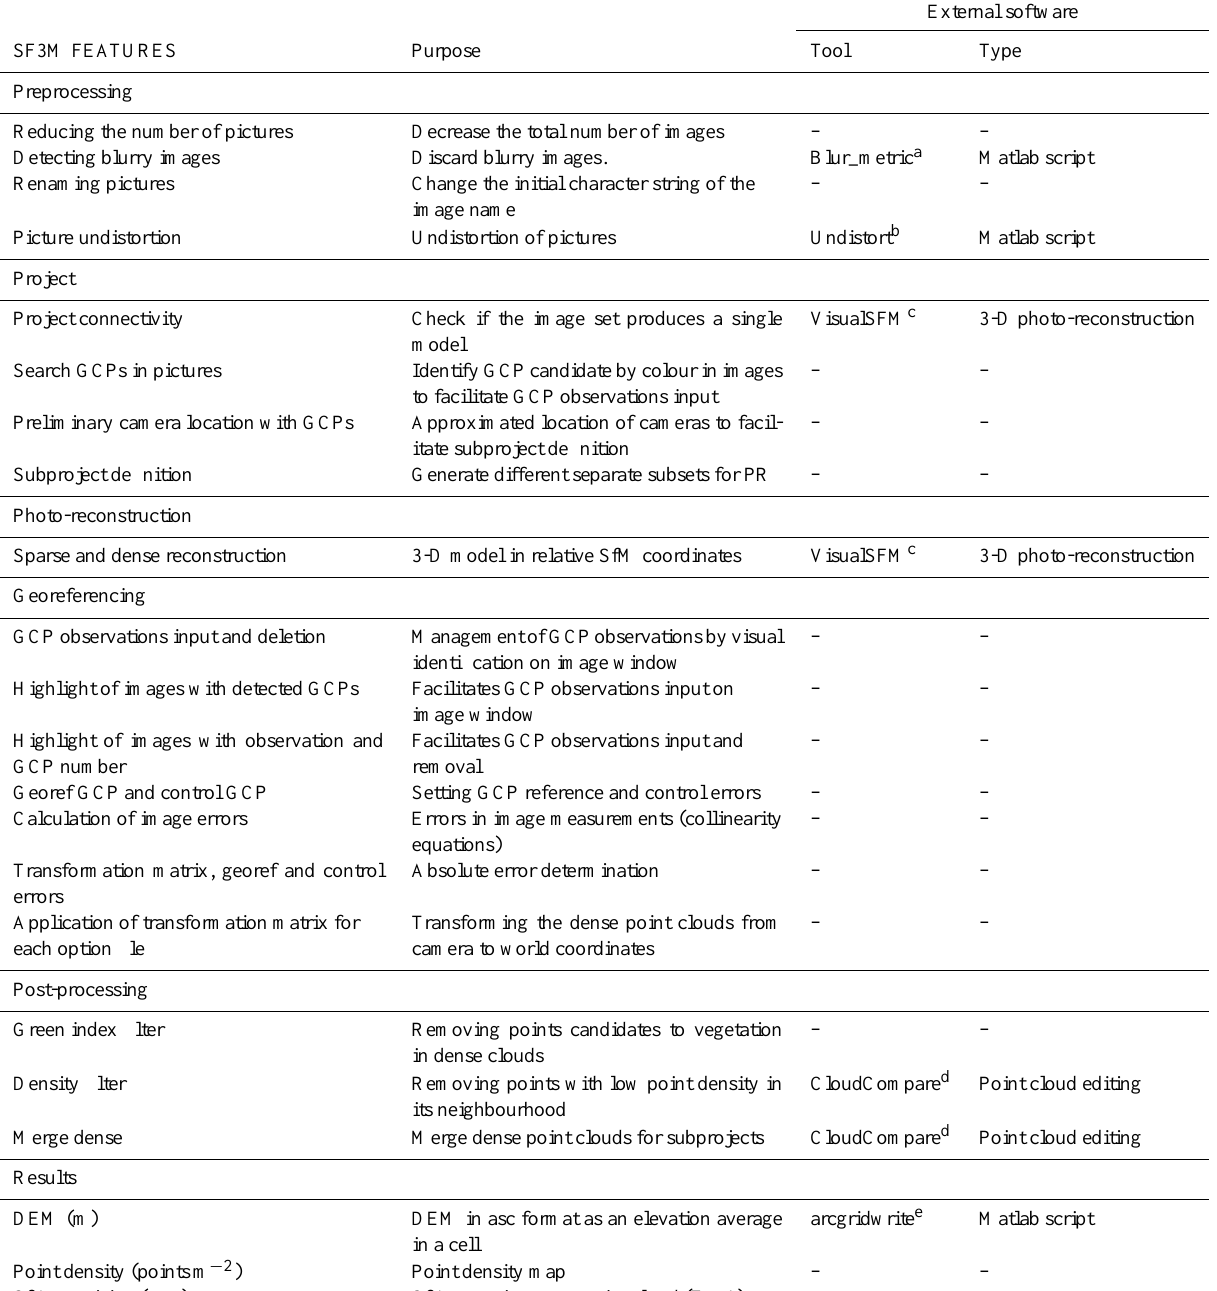
Table 1. SF3M v1.0 features showing the aim of each stage and software